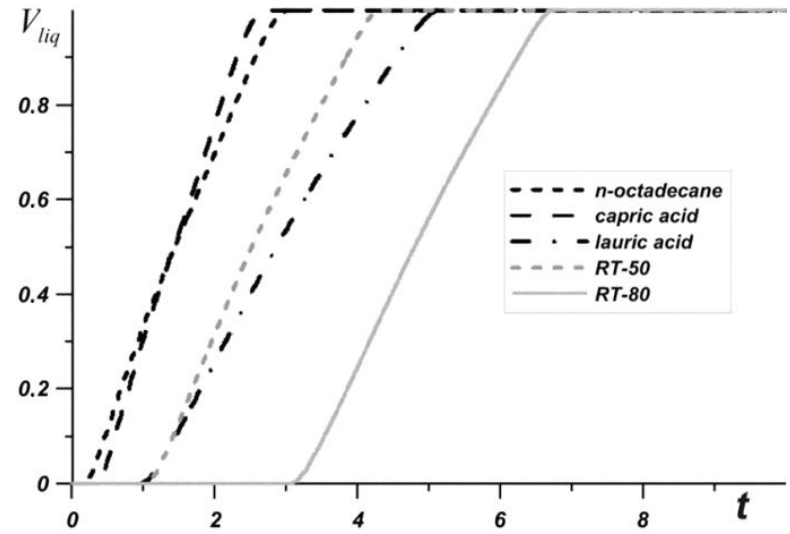
Figure 3. Liquid volume fraction versus time.